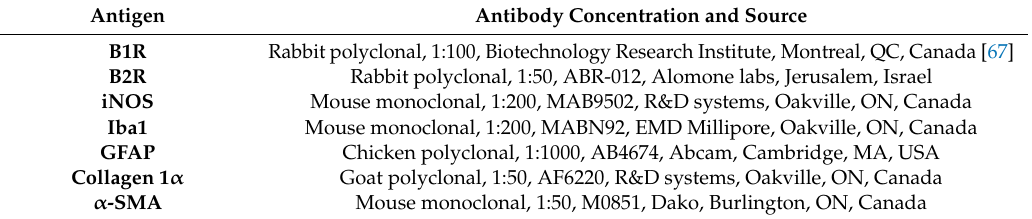
Table 2. List of primary